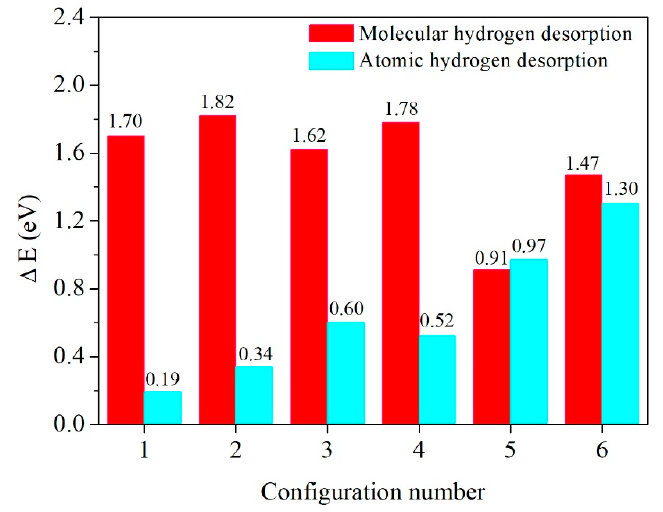
Figure 10. The energy difference ( ∆ E ) between the hydrogen desorption state and the clean TiZrVMoNb hydride (110) surface ( ∆ E = E des − E clean ) for the atomic and molecular hydrogen desorption in the six configurations with an initial height of 3.0 Å.